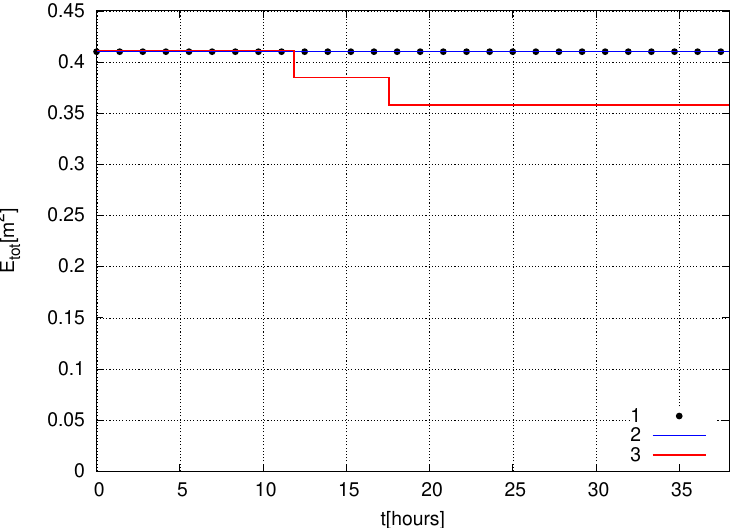
Figure 11. Dependence of the total energy E tot on simulation time for numerical experiments with µ = 0.04 and ˜ k p = 1 in different models. The black solid dots 1 corresponds to the NLS model, the blue solid line 2—to the SCZ equation and the red solid line 3 to the RV